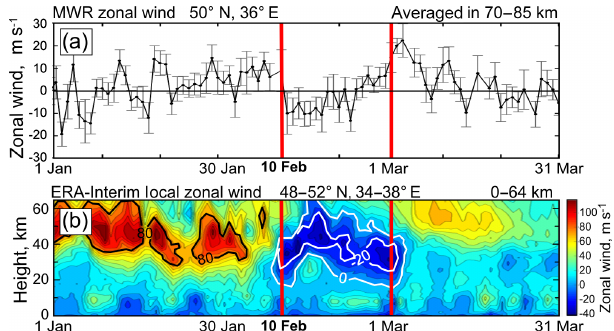
Figure 5. (a) Mesospheric zonal wind microwave measurements over Kharkiv (averaged in altitude range 70–85km, vertical bars are standard deviations) compared to (b) time–altitude local zonal wind from the ERA-Interim reanalysis data averaged over latitudes 48– 52 ◦ N and longitudes 34–38 ◦ E (centered at the Kharkiv microwave radiometer site; 50 ◦ N, 36 ◦ E). The time interval of significant vari- ations in the atmosphere parameters due to the SSW event (from 10 February to 1 March 2018) is bounded by red vertical lines.